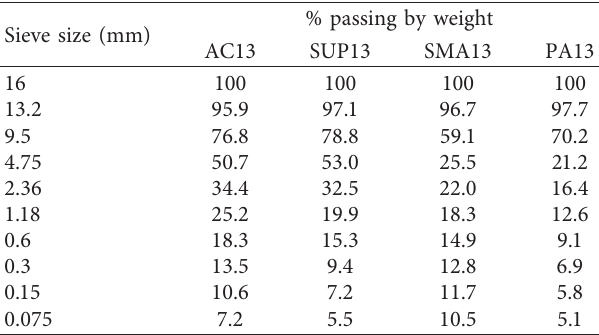
Table 1: Compositions and aggregate gradations of asphalt